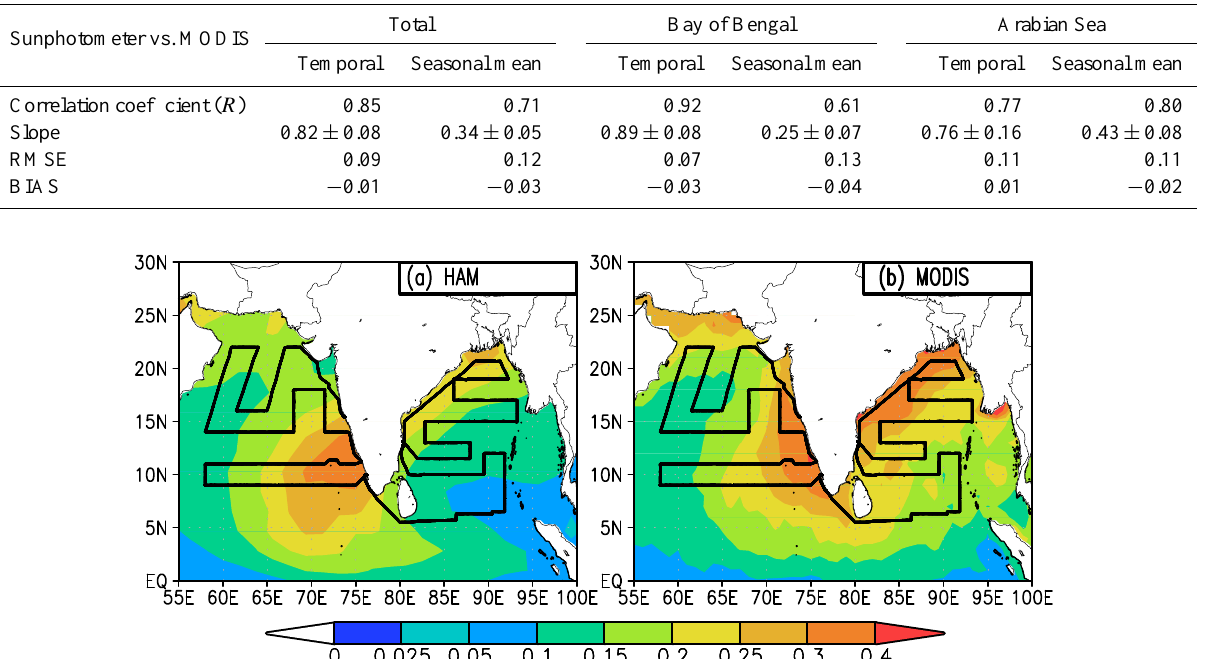
Fig. 2. AOD distributions at 550nm wavelength (a) as simulated by ECHAM5.5-HAM and (b) as retrieved by the MODIS satellite sensors (Terra and Aqua combined), averaged over the ICARB cruise